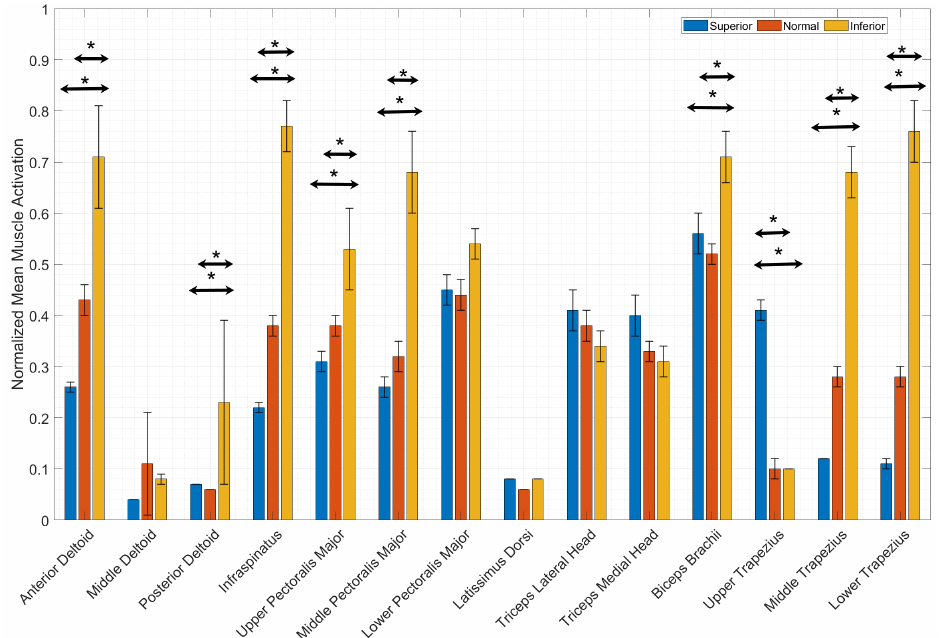
Figure 6. The mean and standard deviation of normalized muscle activities for 14 muscles: the anterior deltoid, middle deltoid, posterior deltoid, infraspinatus, upper pectoralis major, middle pectoralis major, lower pectoralis major, latissimus dorsi, triceps lateral, triceps medial, biceps brachii, upper trapezius, middle trapezius, and lower trapezius muscles in three superior-inferior positions of palms (superior, normal, and inferior). The star sign indicates p -values < 0.05 with respect to Tukey–Kramer post-hoc significant difference